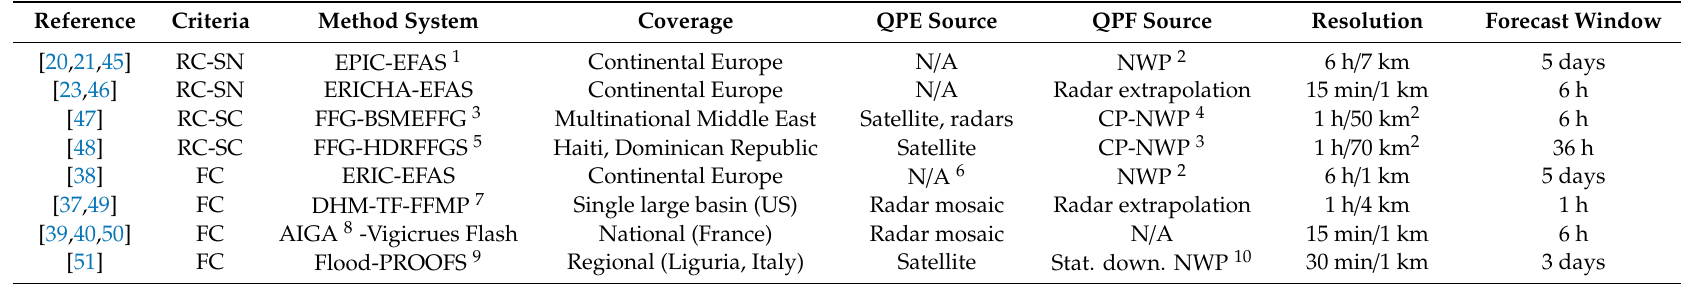
Table 1. Summary of selected reported operational FFEWS systems sorted by criteria.